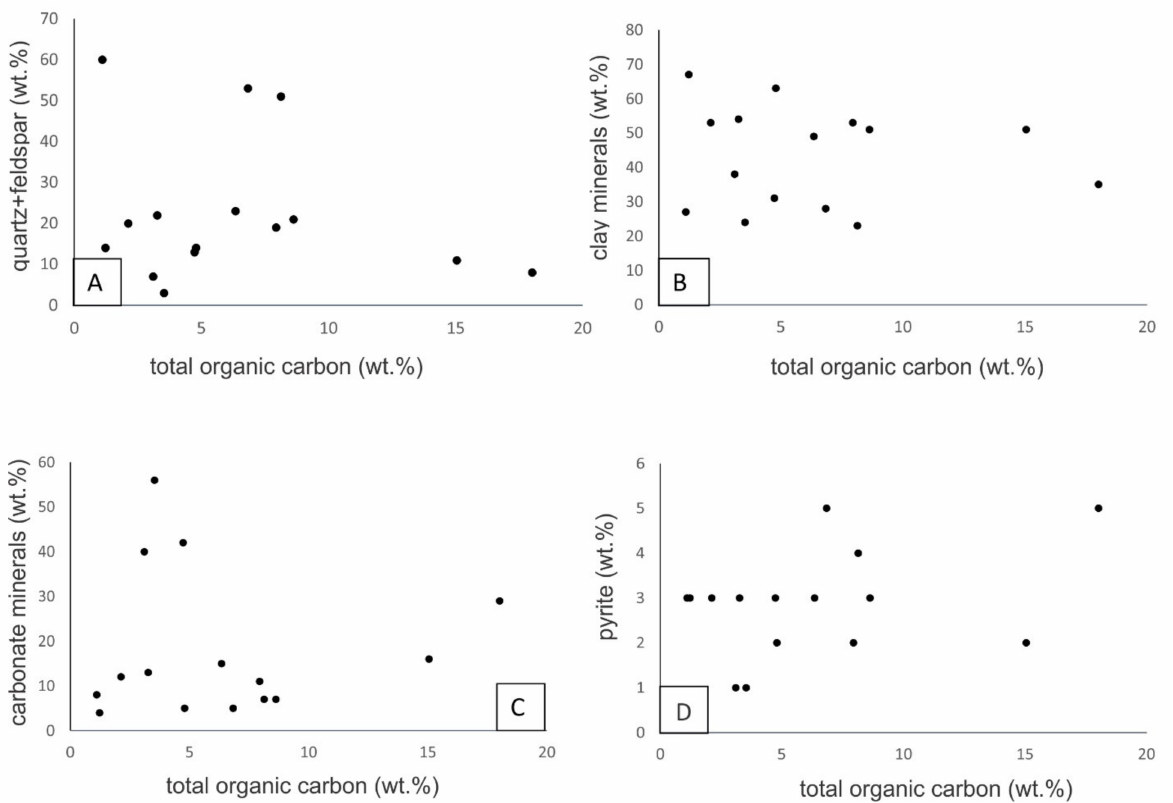
Figure 7. Correlation between total organic content (wt.%) and rock mineralogy (wt.%). ( A ) Correlation of total organic carbon with quartz and feldspar content. ( B ) Correlation of total organic carbon with clay minerals. ( C ) Correlation of total organic carbon with carbonate minerals. ( D ) Correlation of total organic carbon with pyrite